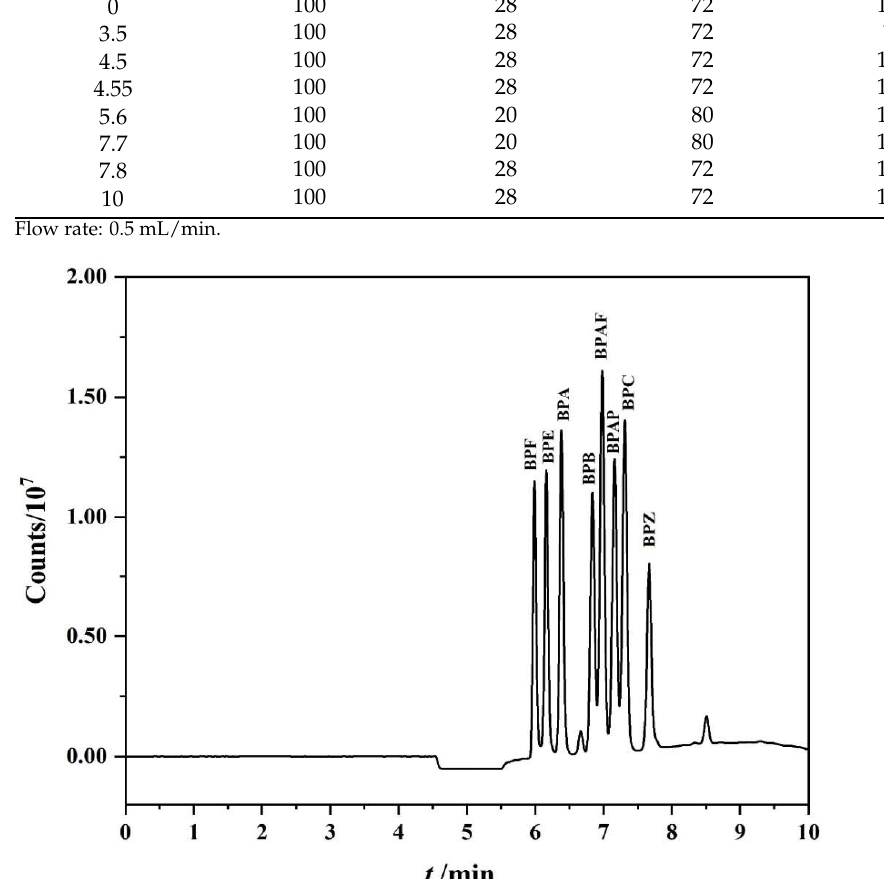
Figure 3. The chromatogram of on−line enrichment and separation of the eight BPs under the opti- optimization mization procedures.